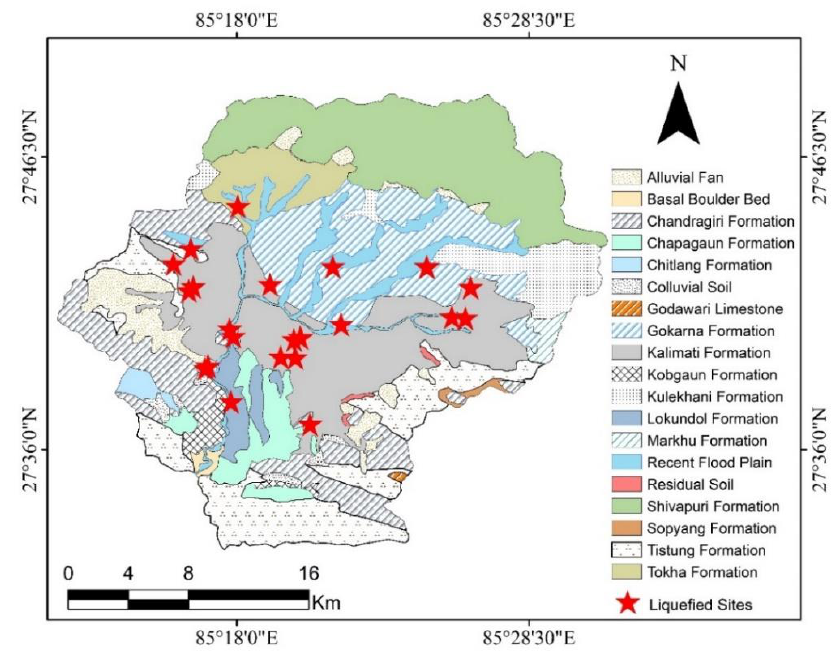
Figure 3. Engineering geological map of Kathmandu Valley (modified after Sakai (Adapted from ref. [41])).